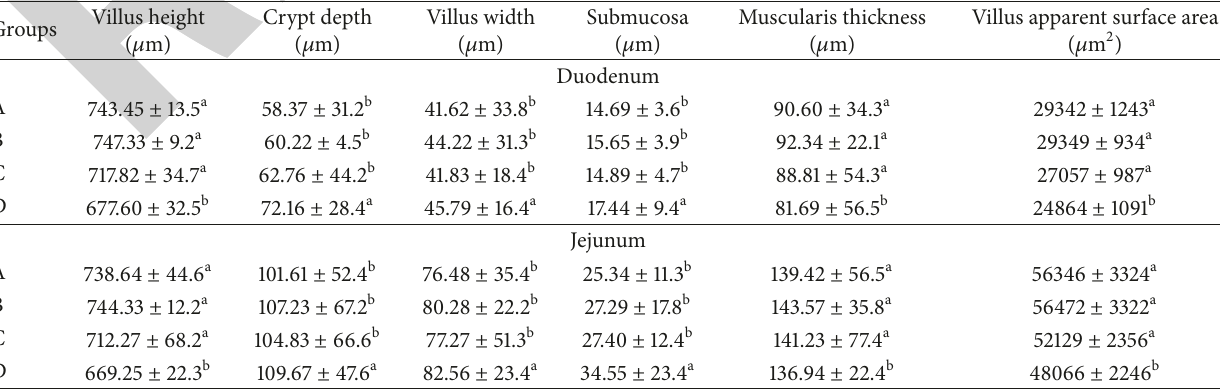
Table 3: Effect of C. perfringens on small intestinal morphology of turkeys (mean ± SD) on day 7 after infection (day 35 after hatch).